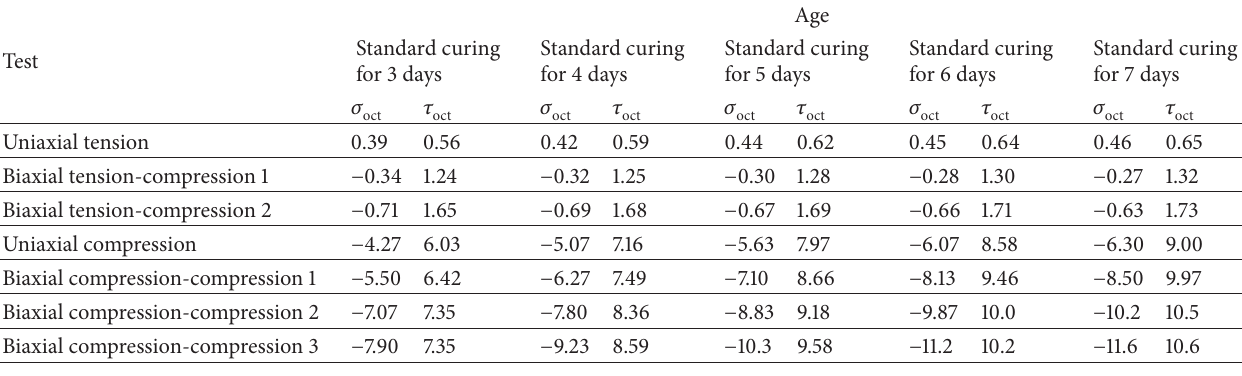
Table 5: The values of normal stressand theshear stressin an octahedral stressspace for theultimate strength of a C20 concrete at an early-age (MPa).